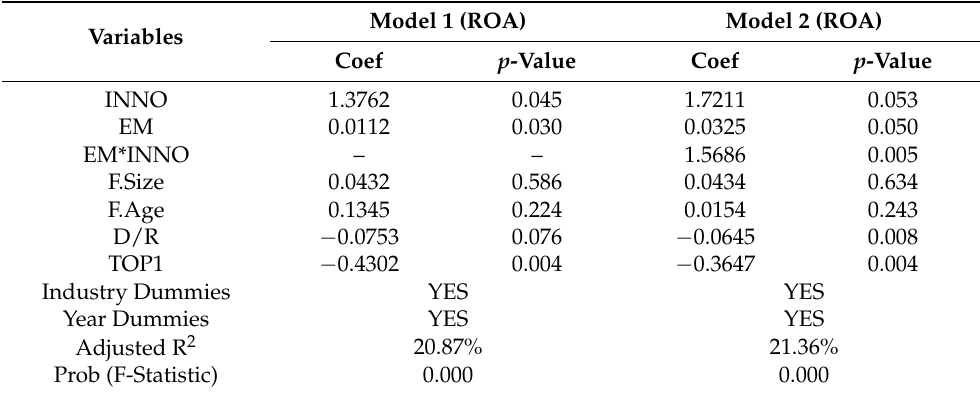
Table 4. Robustness: alternative measure of firm